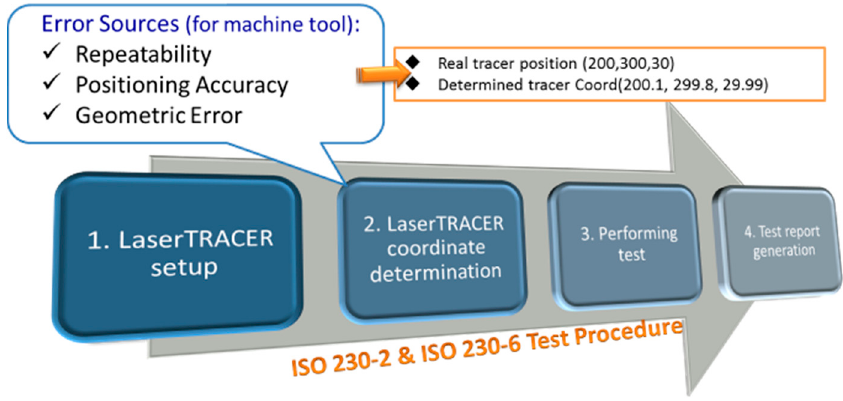
Figure 7. ISO 230 ‐ 2 and ISO 230 ‐ 6 test procedure for testing the machine linear axes positioning accuracy and repeatability.